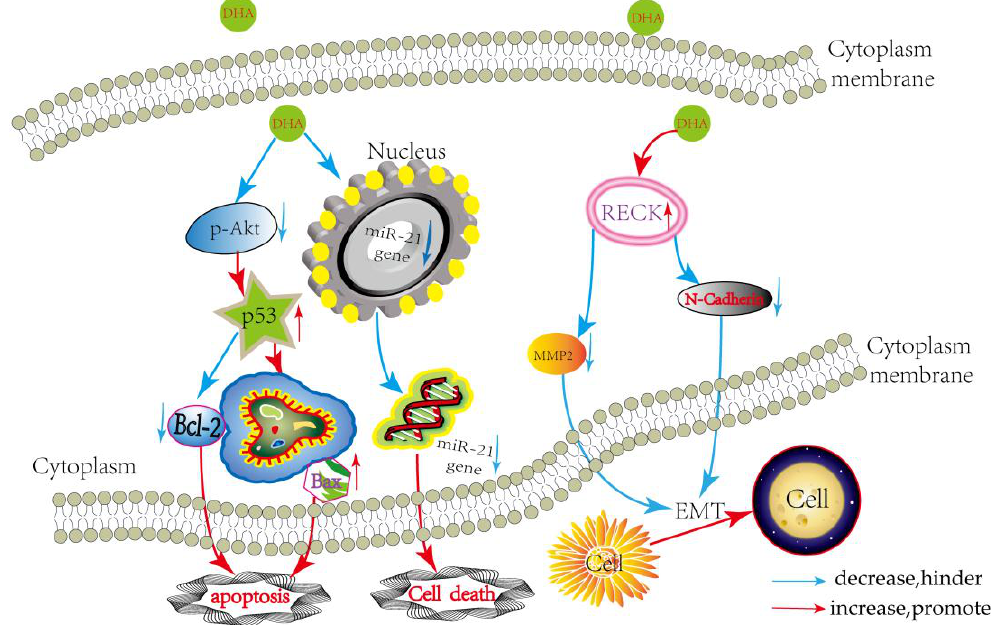
Figure 6. Schematic representation of the signaling pathway mediating DHA lethality to malignant glioma cells.